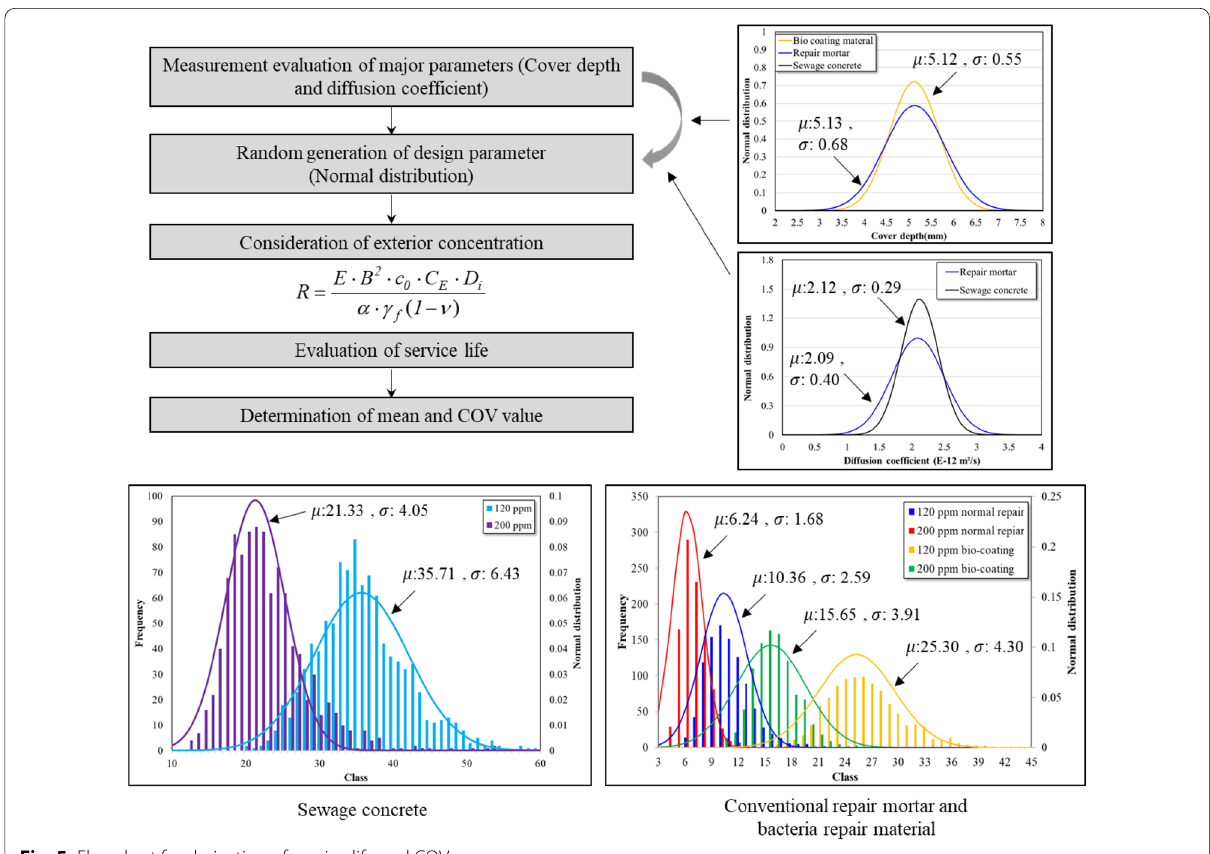
Fig. 5 Flowchart for derivation of service life and COV.